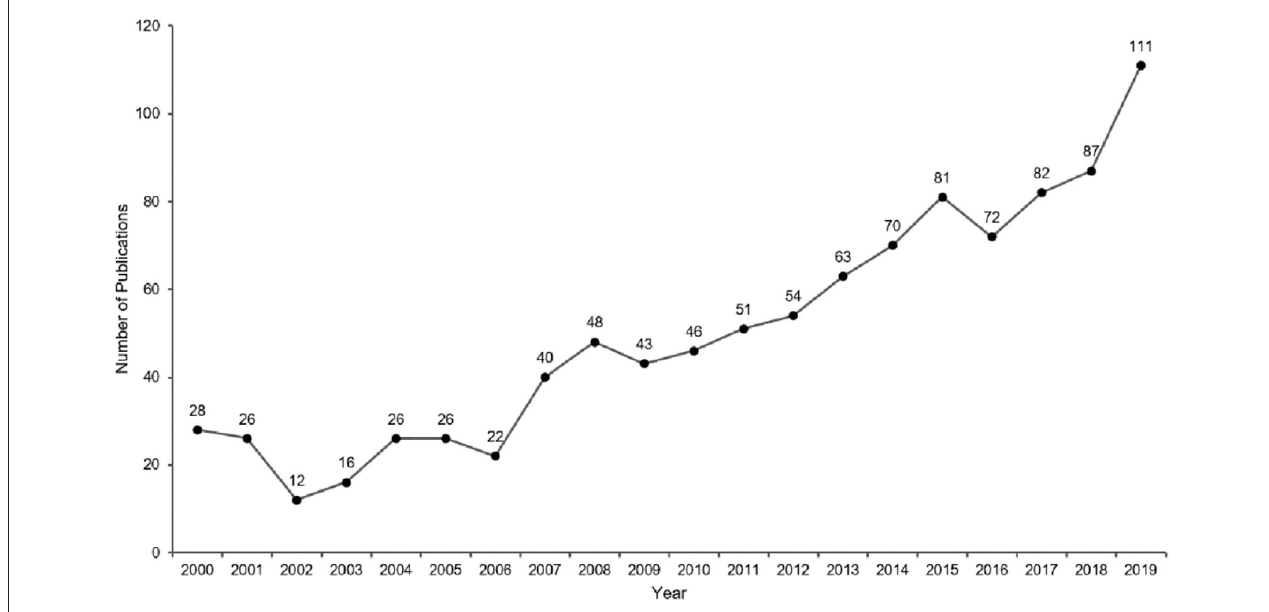
FIGURE 2 | Annual publication outputs of music therapy from 2000 to 2019.